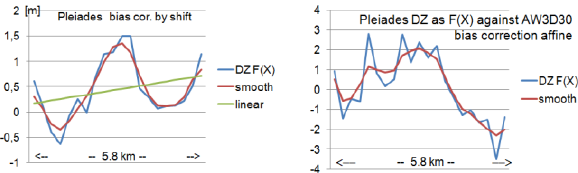
Figure 15. Systematic errors of DZ as function on X against aerial reference (left) and against AW3D30 (right)